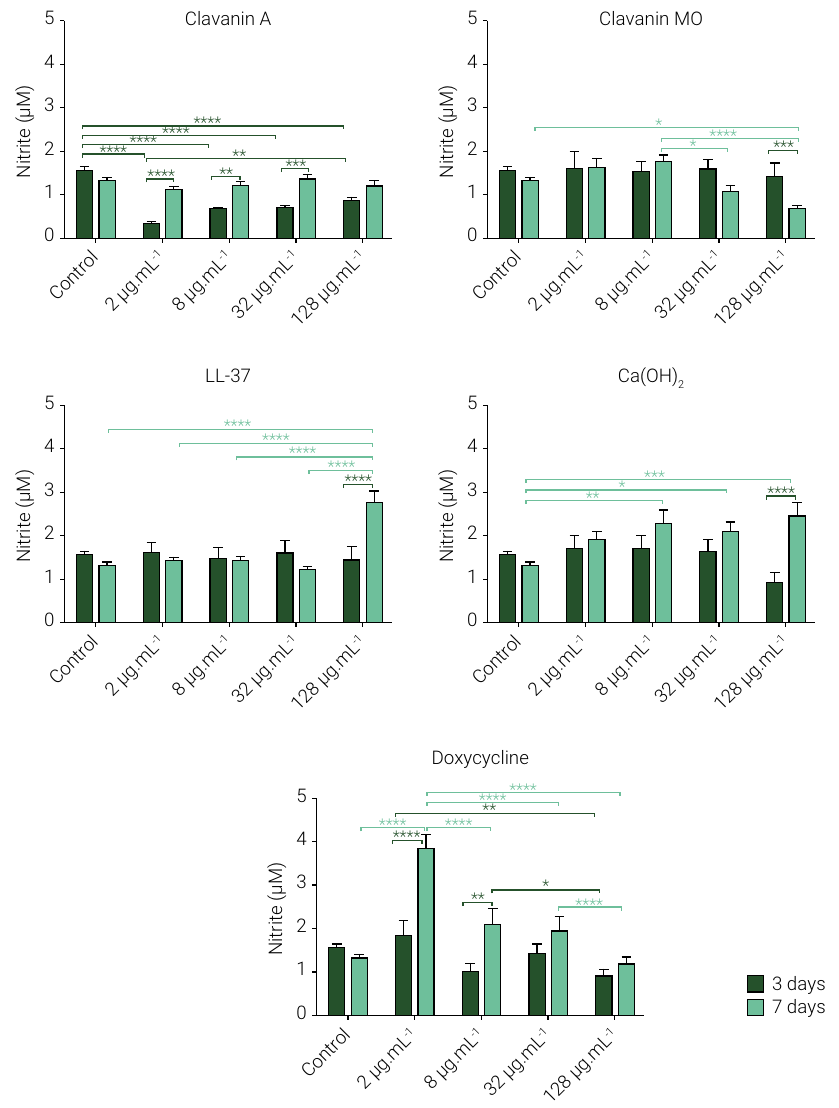
Figure 2. Nitric oxide production in the presence of clavanin A, clavanin MO, LL-37, Ca(OH) at 2, 8, 32 and 128 μg.mL -1 on rRANKL-stimulated-RAW cells, after 3 and 7 days, as described in the method of Green et al., with adaptations. Cultures were stimulated with 100 ng.mL -1 of rRANKL. Control group consisted of 2.5x10 3 RAW cells stimulated with 100 ng.mL -1 of rRANKL. Bars represent the standard error of the mean of nitrite oxide production. All experiments were done in technical and biological triplicates. Statistical differences by two-way ANOVA test and Tukey’s post hoc were represented by *p<0.05, **p<0.005, ***p<0.0005 and ****p<0.0001 compared to each concentration and time-tested conditions; Dark green bars represent statistical differences observed on day 3; Light green bars represent statistical differences observed on day